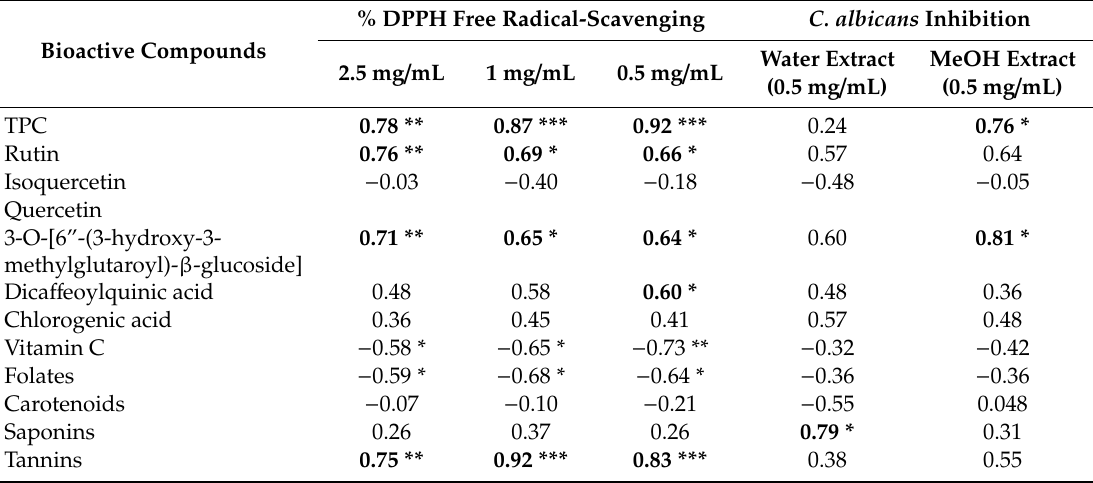
Table 6. Pearson’s correlation coe ffi cients between bioactive compounds, DPPH radical-scavenging capacity and antifungal activity.